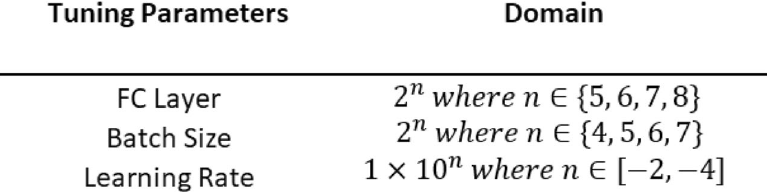
Table 4 Domain for the